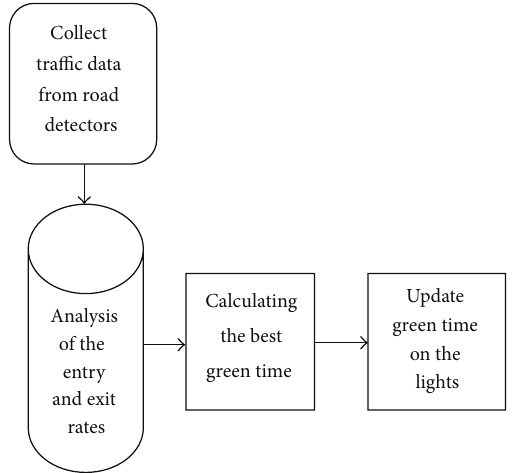
Figure1:Schemeoftrafficoptimizationprocessusingdatacollected from road detectors.